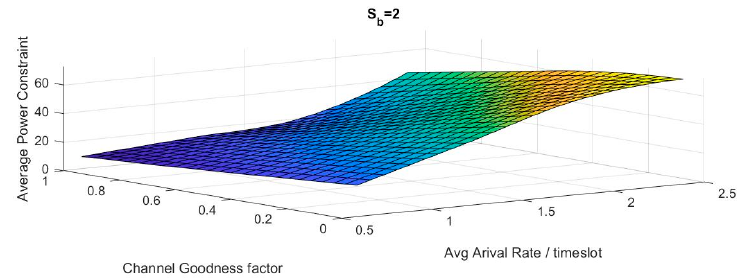
Figure 7. Realistic channel-aware system power performance interpolation.